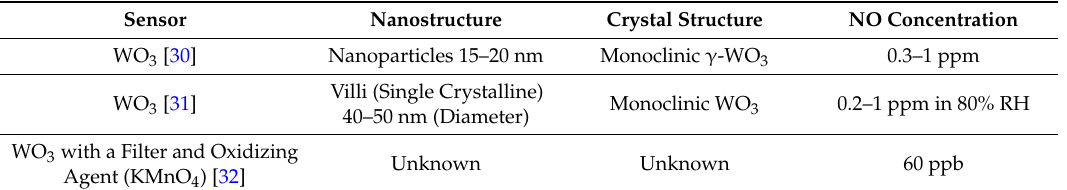
Table 8. A list of different samples used to detect NO.